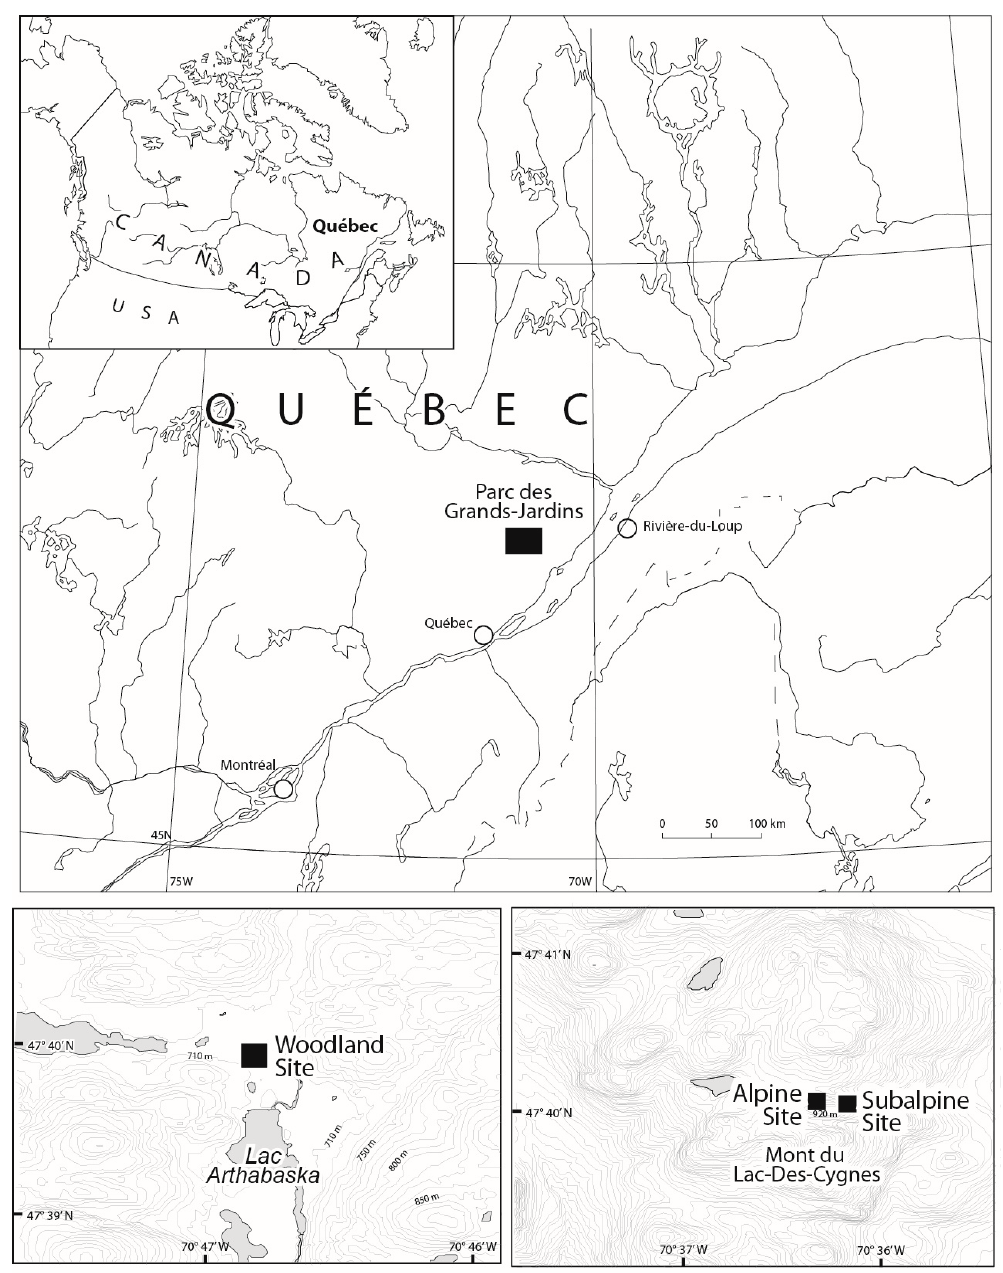
Figure 1. Location of the study area in southern Quebec, Canada.